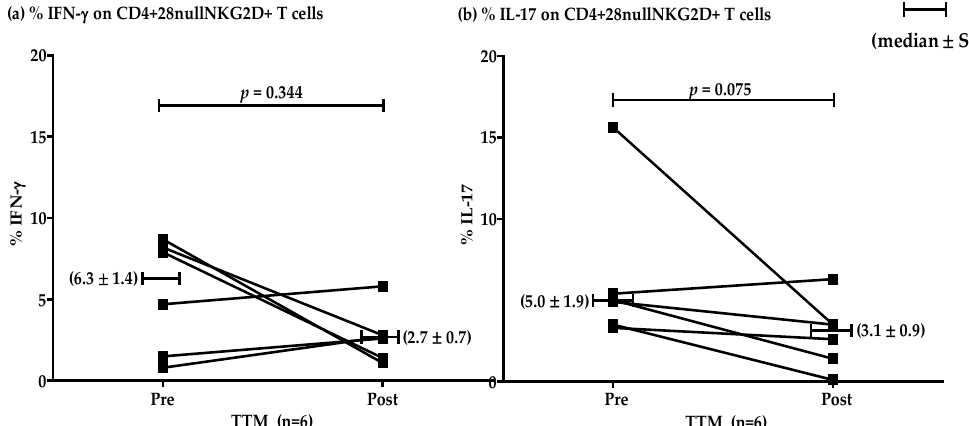
Figure 4. Representative plotting line graph ( n = 6) displaying the comparison of the percentages of CD4+CD28 null NKG2D+ T cells producing IFN- γ ( a ) and IL-17 ( b ) at pre- and post-TTM phase. The data are shown by median ± SE. IFN- γ production pre and post was 6.3 ± 1.4 and 2.7 ± 0.7, respectively. IL-17 production pre and post was 5.0 ± 1.9 and 3.1 ± 0.9, respectively. Data were analyzed by Wilcoxon Signed Rank test. p -value < 0.05 was determined as a significant difference.